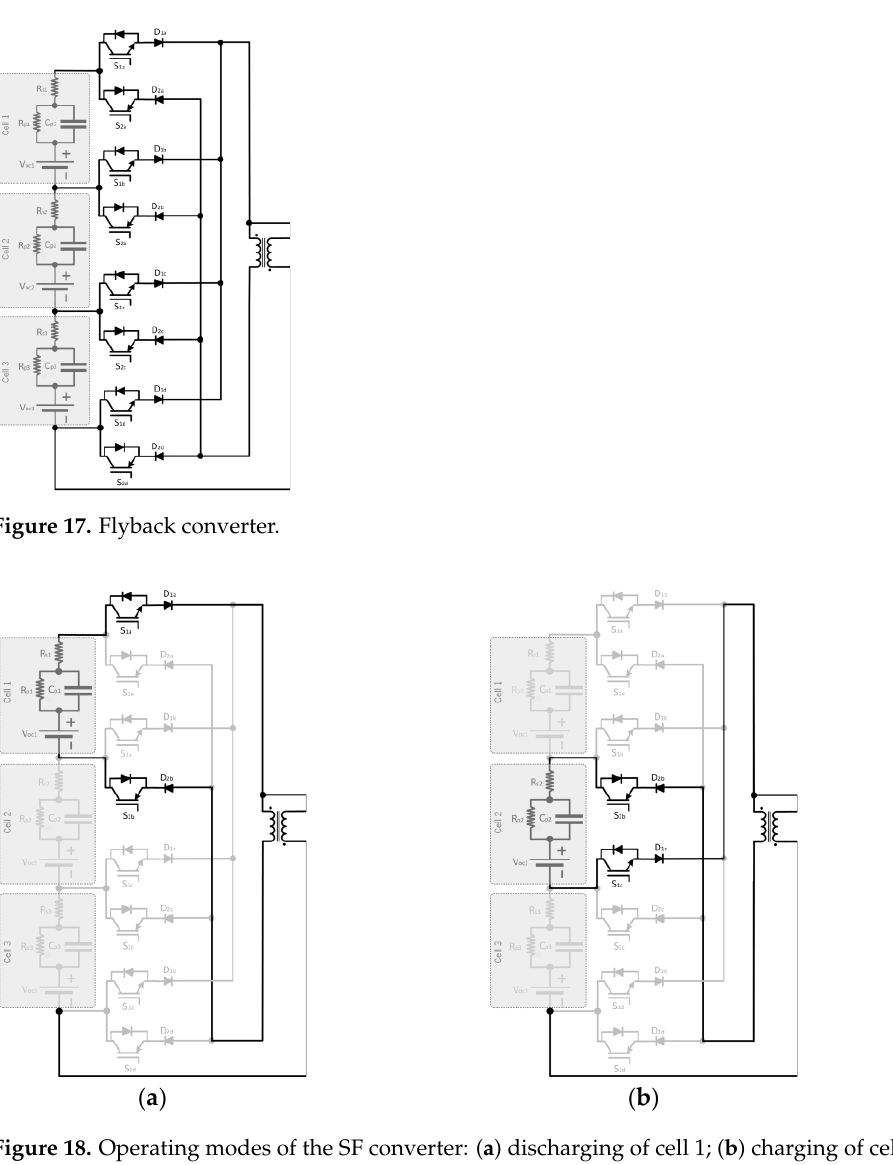
( b ) Figure 16. Operating modes of the Cuk converter: (a) discharging of cell 1; ( b ) charging of cell 2. 2.7. Single Flyback The single flyback (SF) converter, which is represented in Error! Reference source not found. , uses a transformer to balance the cells. The single transformer balancing method shares the same topology as the SI. Thus, as illustrated in Error! Reference source